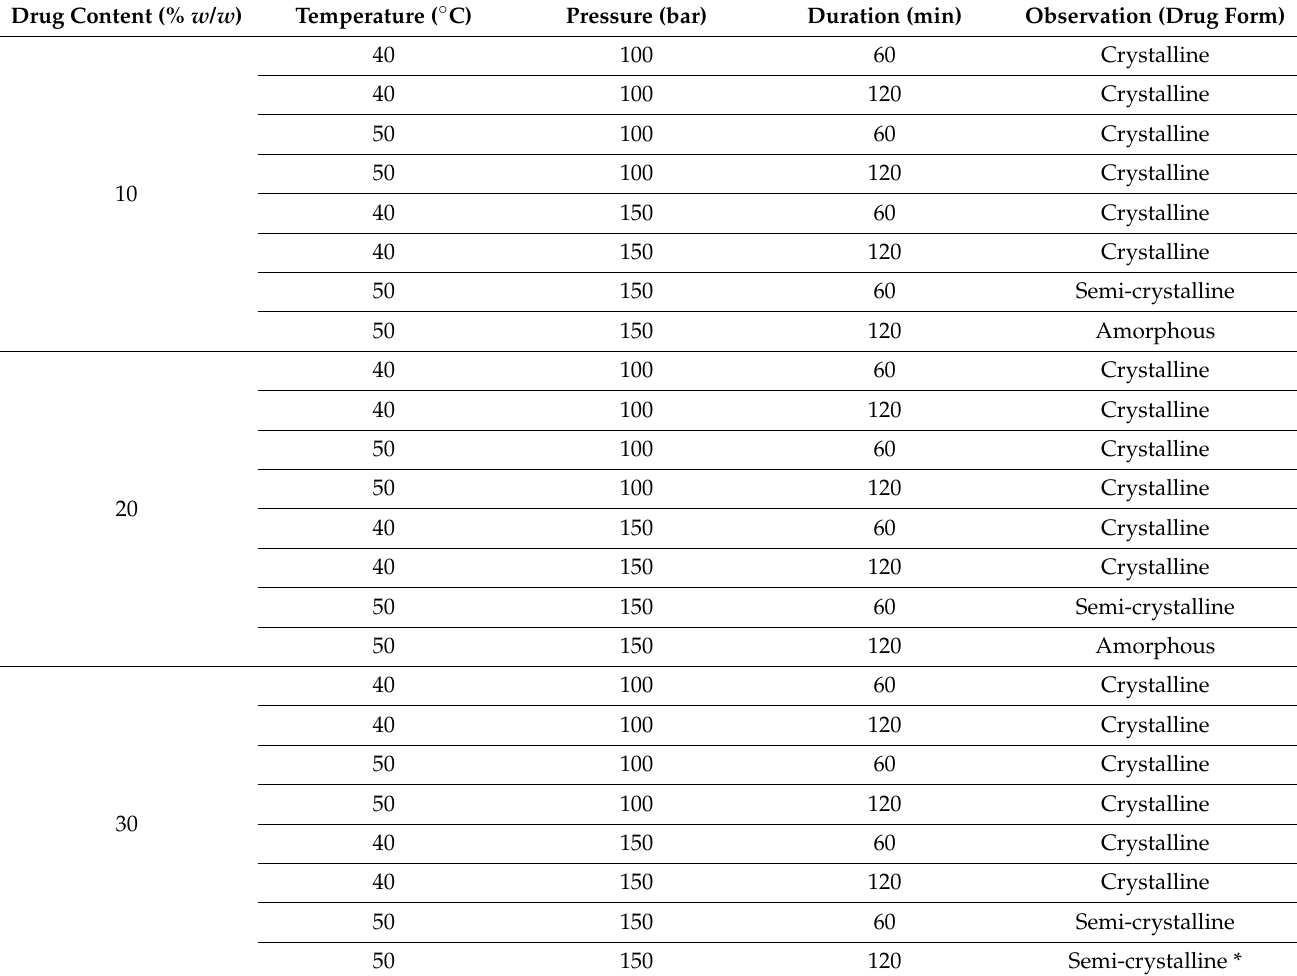
Table 2. Solid dispersion of simvastatin in Soluplus via scCO 2